Question: Condense the content of this figure into a single sentence.
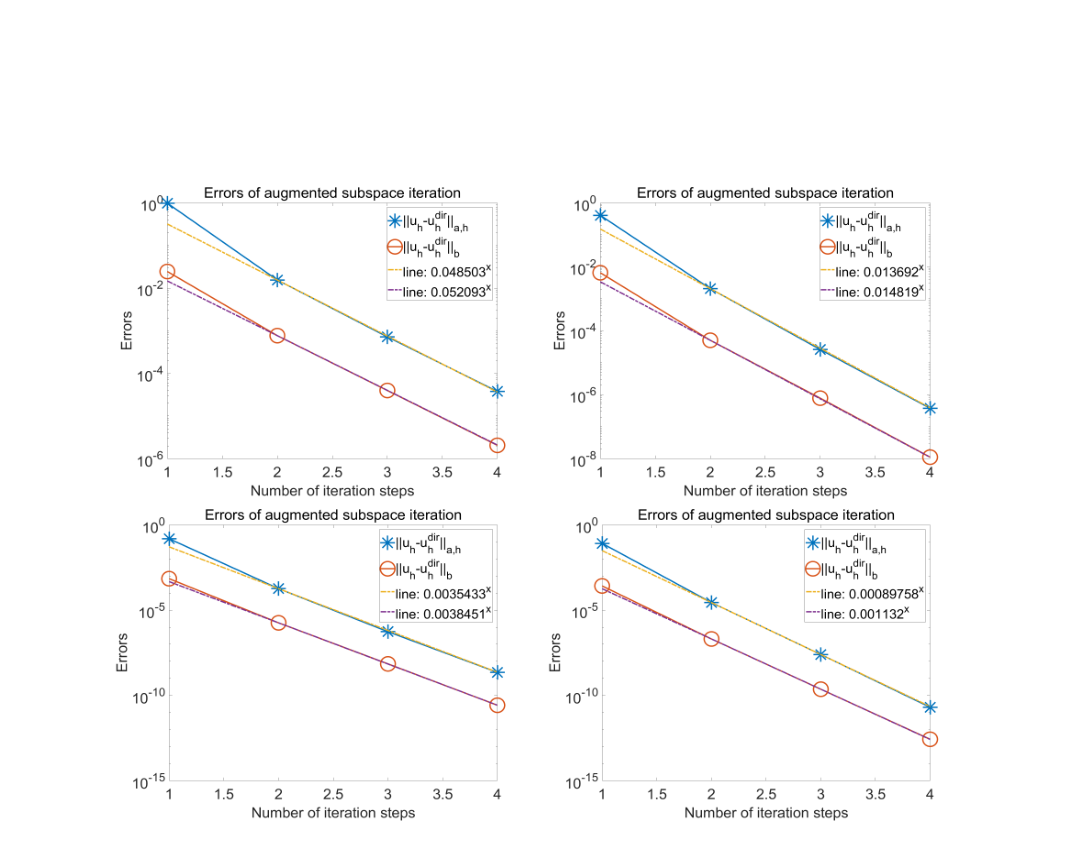
Answer: shows the convergence behaviors for the first eigenfunction by the augmented subspace methods corresponding to the coarse mesh size H = √